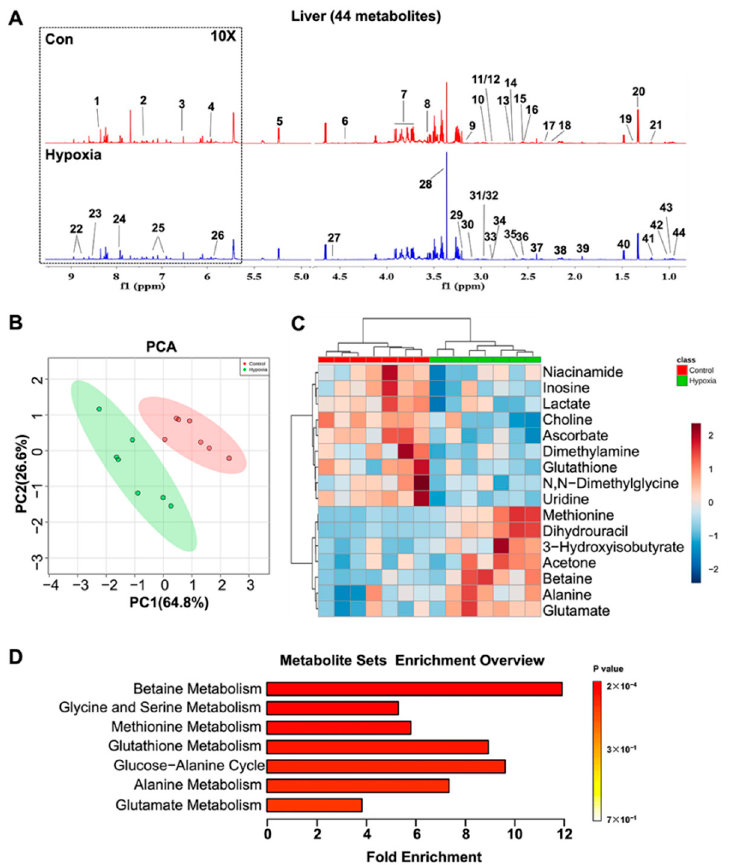
Figure 4. Metabolomic analysis of the liver. ( A ) Representative 1D 1 H NMR spectra of aqueous extracts derived from the liver. 1, Inosine; 2, Phenylalanine; 3, Fumarate; 4, Uridine; 5, Mannose; 6, Glycerophosphocholine; 7, Glucose; 8, Glycine; 9, β -Alanine; 10, N,N-Dimethylglycine; 11, Asparagine; 12, Aspartate; 13, Sarcosine; 14, Dimethylamine; 15, Malate; 16, Dihydrouracil; 17, Glutamate; 18, Acetone; 19, 2-Phenylpropionate; 20, Lactate; 21, 3-Hydroxyisobutyrate; 22, Niacinamide; 23, Adenosine 5’-monophosphate; 24, Histamine; 25, Tyrosine; 26, Uracil; 27, Ascorbate; 28, Betaine; 29, Choline; 30, Ornithine; 31, N-Methylhydantoin; 32, Creatine phosphate; 33, Methylguanidine; 34, Trimethylamine; 35, Methionine; 36, Glutathione; 37, Succinate; 38, Glutamine; 39, Acetate; 40, Alanine; 41, Ethanol; 42, Valine; 43, Leucine; 44, Isoleucine. ( B ) PCA score plot, illustrating a metabolic difference between hypoxic mice and controls. The x -axis represents the first PC accounting for 64.8% of the total variation, and the y -axis denotes the second PC accounting for 26.6% of the total variation. Ovals in the panel highlight the metabolic distinction between two groups. ( C ) Clustered heatmap plot of relative metabolite levels, showing metabolic derangement. ( D ) Significantly altered metabolic